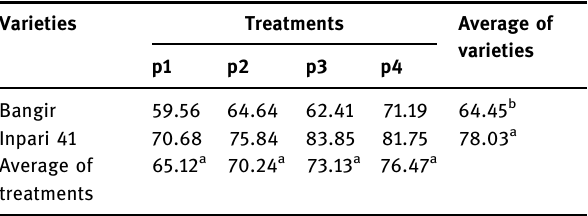
Table 6: Comparisons of weight of grain per plant ( g ) of two rice varieties fertilized with di ff erent types of organic manure Varieties Treatments Average of